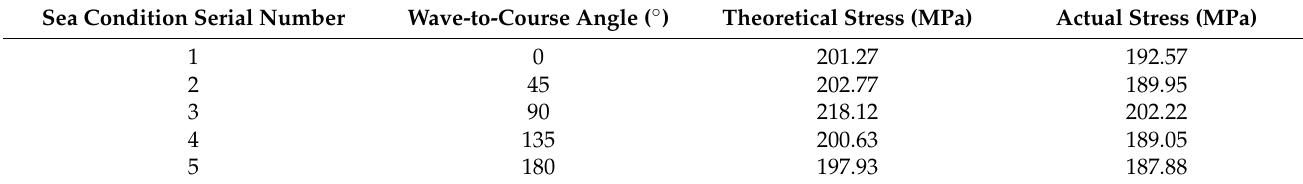
Table 8. Maximum tower stress during piping-laying (measuring point 1).